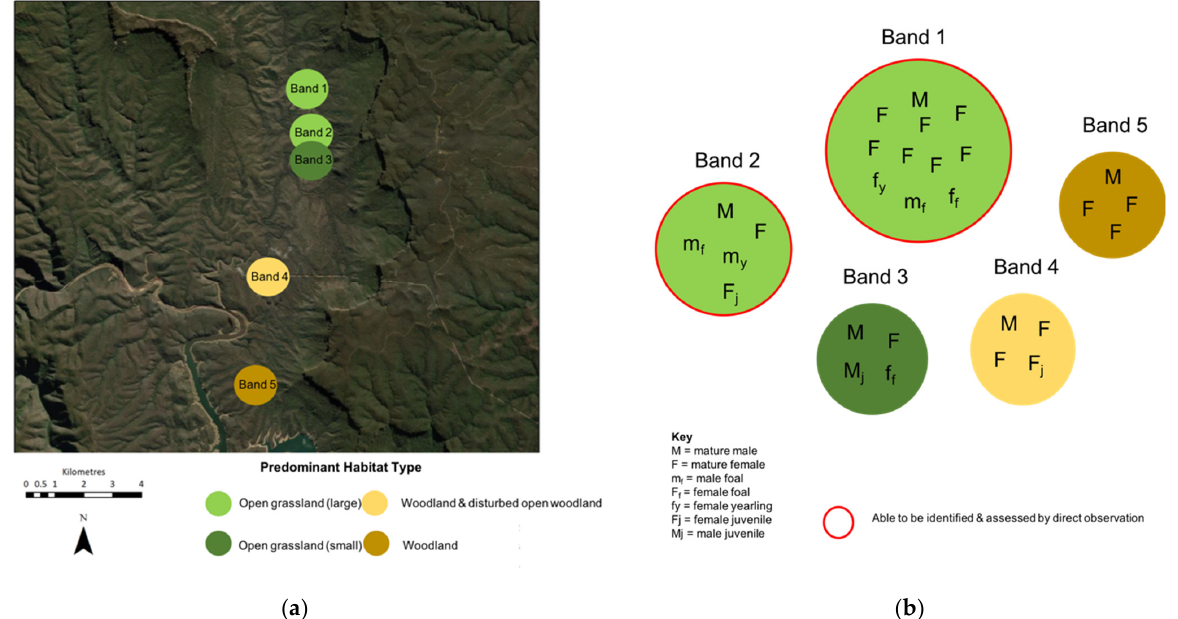
Figure 5. Illustration of ( a ) the geographical location and predominant habitat type of the different bands, and ( b ) band compositions. Only horses in Bands 1 and 2 that resided on larger open grassland habitats could be identified and assessed by direct observation. Horses in all other bands and habitats could only be identified and assessed with remote camera traps.